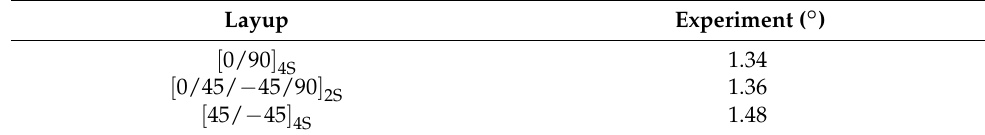
Figure 2. The predicted spring-back angel of the composites with layup [0/90]4S and schematic of laser scanning experiment. Table 1. The measurement value of the spring-back